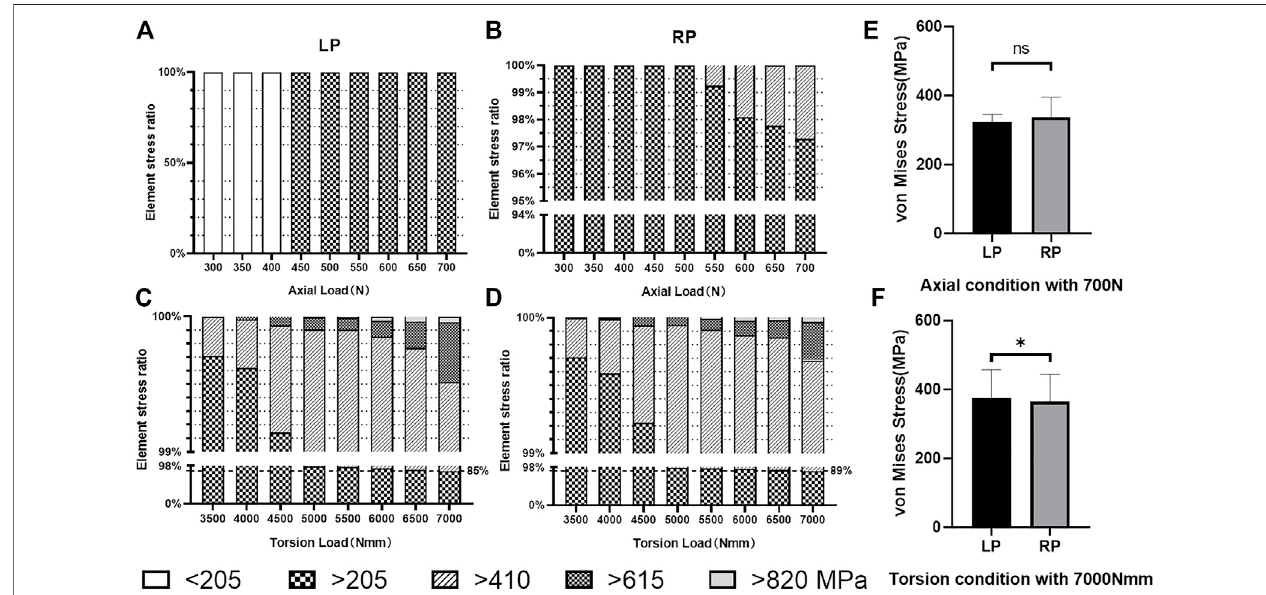
FIGURE 6 | Elemental stress distribution. (A) Stress distribution under load values of the LP plate element in axial compression load conditions. (B) Stress distribution under load values of the RP plate element in axial compression load conditions. (C) Stress distribution under load values of the LP plate element in torsional load conditions. (D) Stress distribution under load values of the RP plate element in torsional load conditions. (E) Number of the elements which exceeds the allowable stress of 275 MPa under axial compression conditions in twice that of the physiological load case ( p > 0.05). (F) Number of elements which exceeds the allowable stress of 275 MPa under torsion conditions in twice that of the physiological load case ( p <